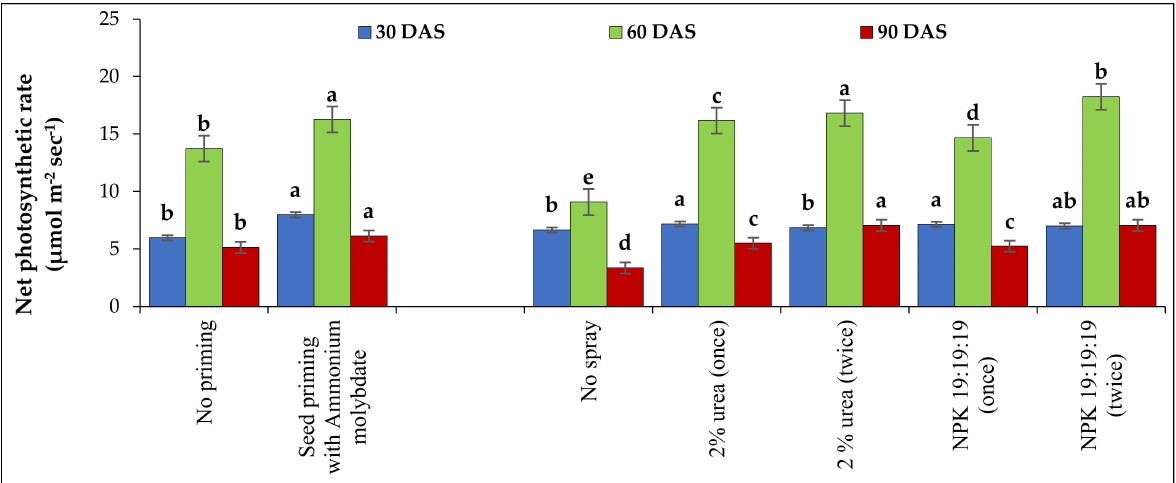
Figure 5. Effect of seed priming and foliar sprays on net photosynthetic rate of grass pea at different growth stages (pooled means of 2 years) (Different letters in all bars indicate significant differences between means.)